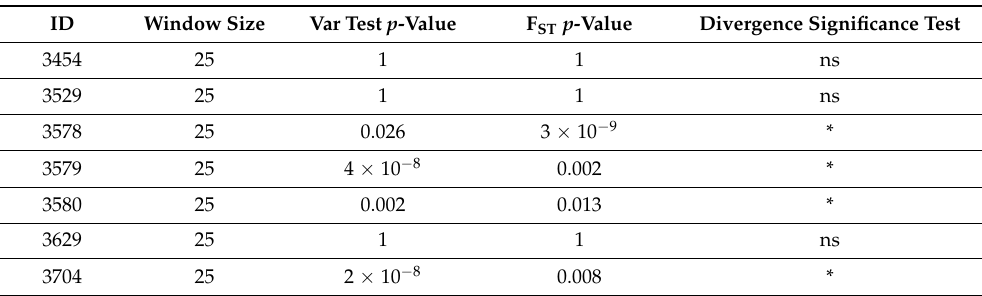
Table 6. Homogeneity variance test for divergent selection for the Atlantic–Cantabric comparison. ID: SNP ID in Table S4 (e.g., ID 3579 corresponds to SNP ctg7180001794010_7928_SCT in the region with the gene symbol LOC106586750 corresponding to m MEP-2*). Var test p value: minimum p